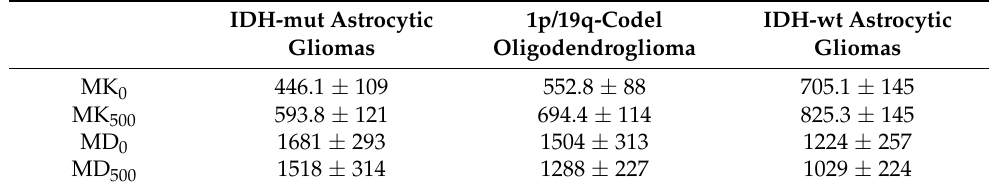
Table 5. MK and MD values of the three glioma subgroups (MK metrics are dimensionless, MD in 10 − 6 × mm 2 /s).